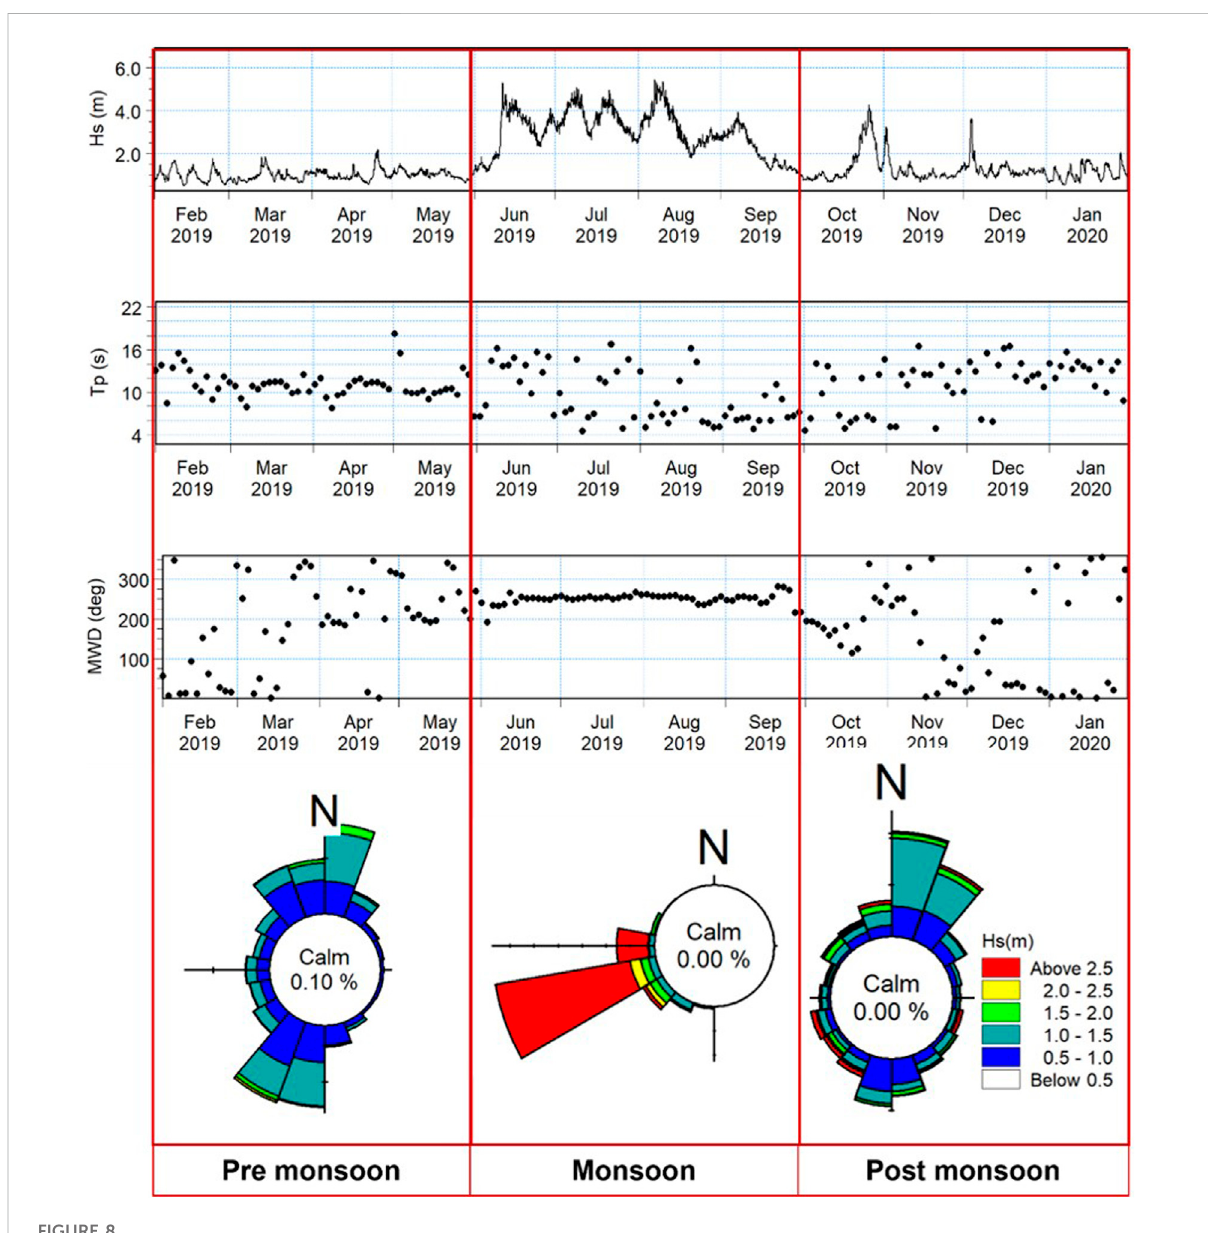
FIGURE 8 Distribution of signi fi cant wave height (Hs), peak wave period (Tp) and mean wave direction ( θ ) of waves for the period from February 2019 to January